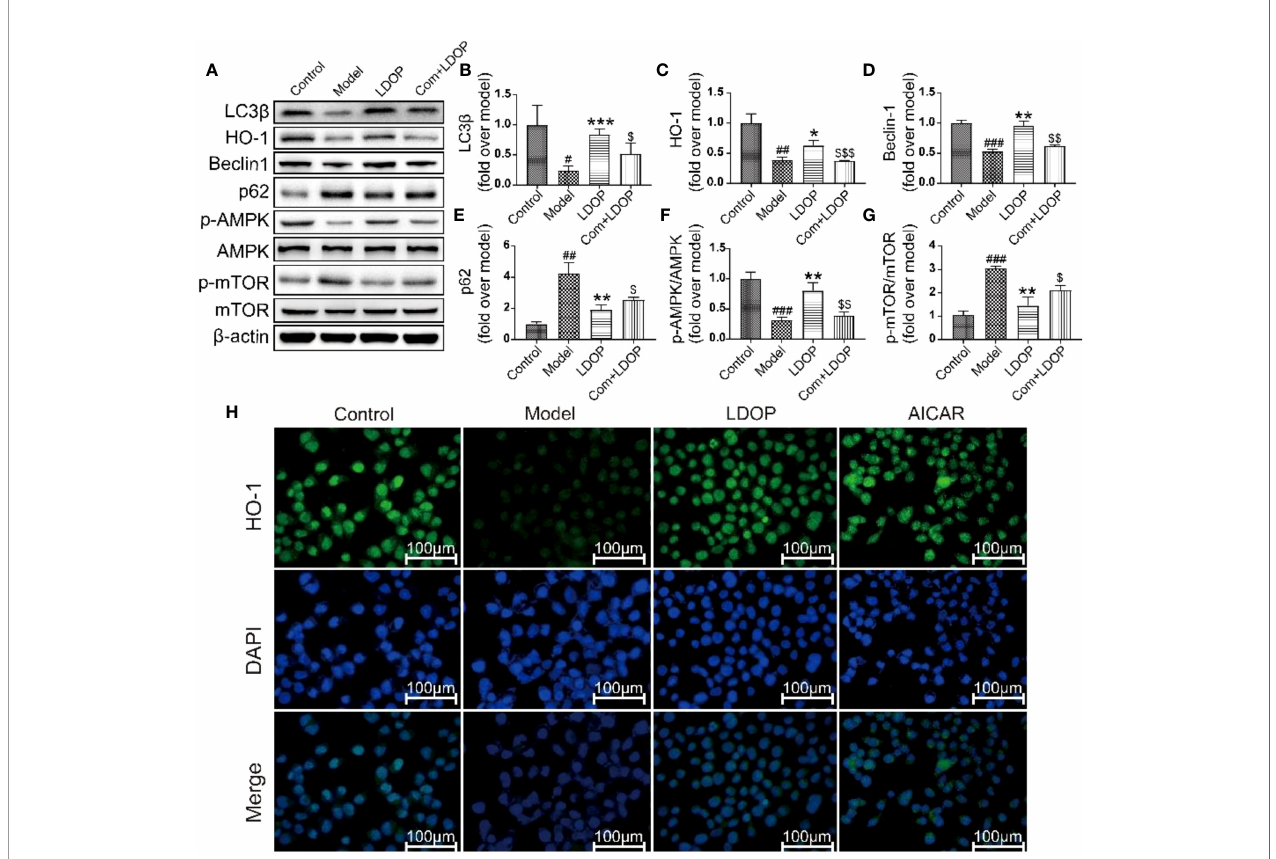
FIGURE 10 | LDOP-1 could activate the autophagy by mTOR/AMPK signaling way in vitro. (A) The expression of LC3 b , HO-1, Beclin-1, p-AMPK, p62, p-mTOR detected by Western blot. (B-G) Statistical analysis on LC3 b , HO-1, Beclin-1, p-AMPK, p62, p-mTOR. Immunohistochemical image of HO-1 (H) measured by immuno fl uorescence technique. Data are expressed as the mean±SD of three independent experiments. # P < 0.05, ## P<0.01, ### P < 0.001 compare the control group; *P<0.05 and **P<0.01, ***P < 0.001 compare model group, $ P<0.05, $$ P<0.01, $$$ P < 0.001 compared with LDOP-1 group. LDOP stood for